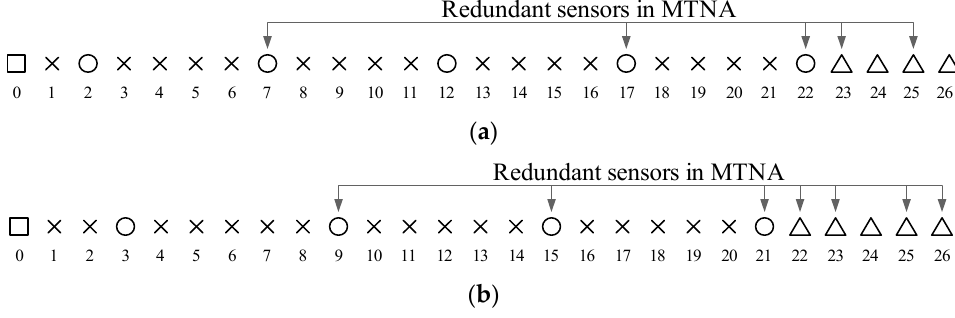
Figure 1. Two examples of modified translational nested array (MTNA), where the number of sensors is 10. ( a ) The structure of MTNA with N 1 = 4 and N 2 = 5, where the redundant sensors { 23 } and { 25 } are two alternatives, and the same applies to { 7,22 } and { 17,22 } . ( b ) The structure of MTNA with N 1 = 5 and N 2 = 4, where the redundant sensors { 22,23 } and { 25,26 } are two alternatives, and the same applies to { 9,21 } and { 15,21 } . Black squares represent the sensors located at zero point in MTNA, while black triangles and circles denote sensors of S 1, a and S 2, a in MTNA, respectively.